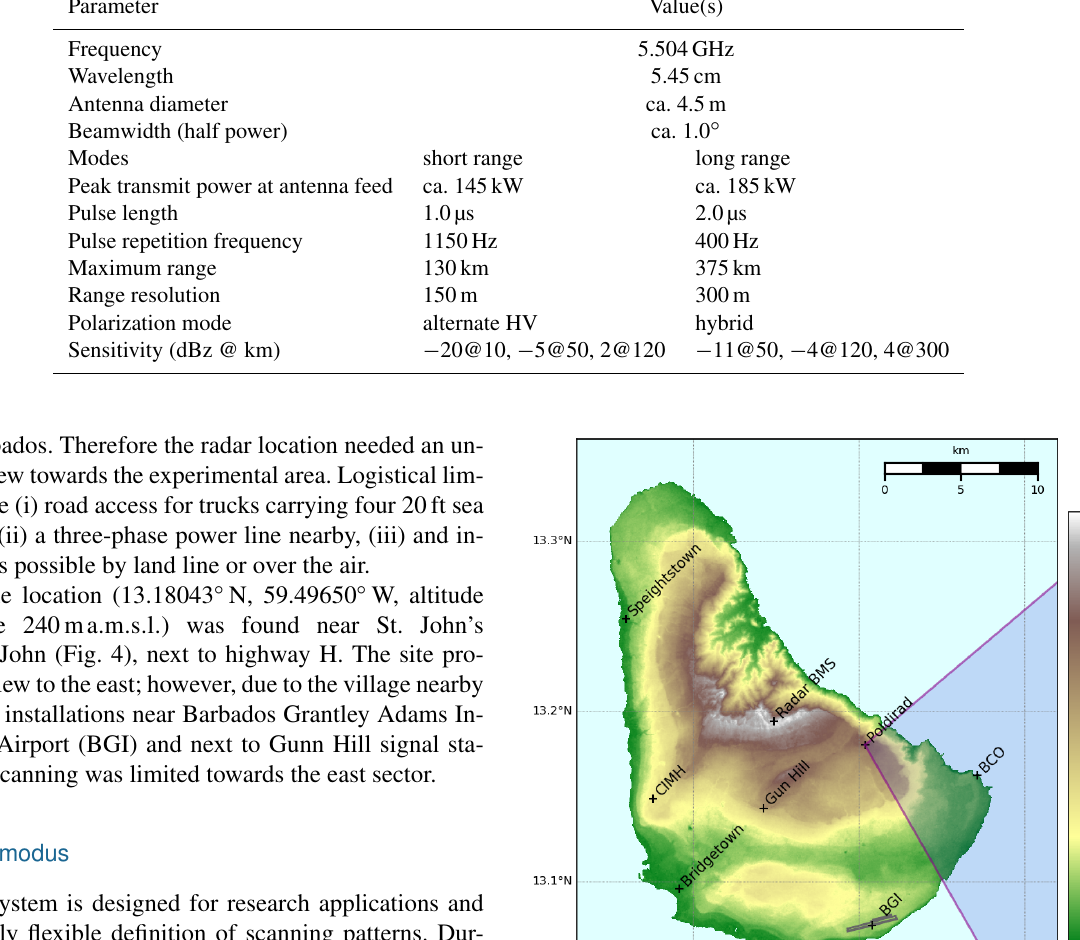
Figure 4. Location of Poldirad on Barbados. Shaded region shows scanning sector. BCO: Barbados Cloud Observatory; BGI: